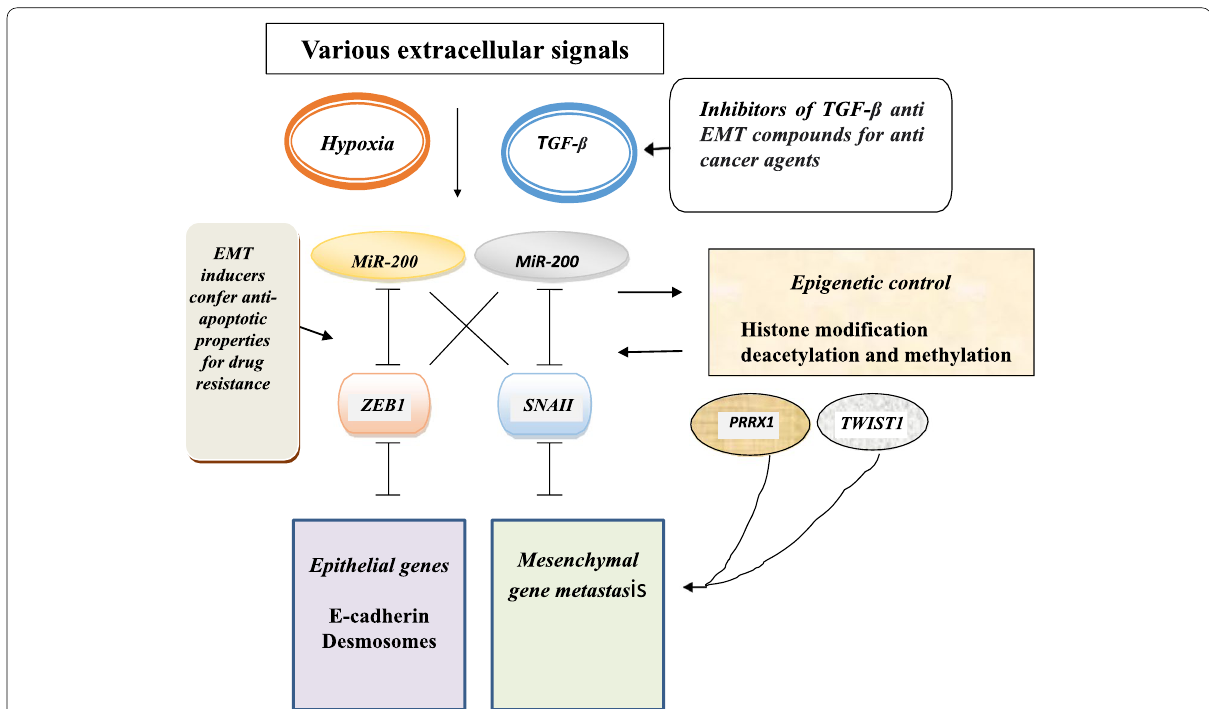
Fig. 3 EMT controlling network: important sites discussing both chemoresistance and anti-EMT agents/representatives for therapy of